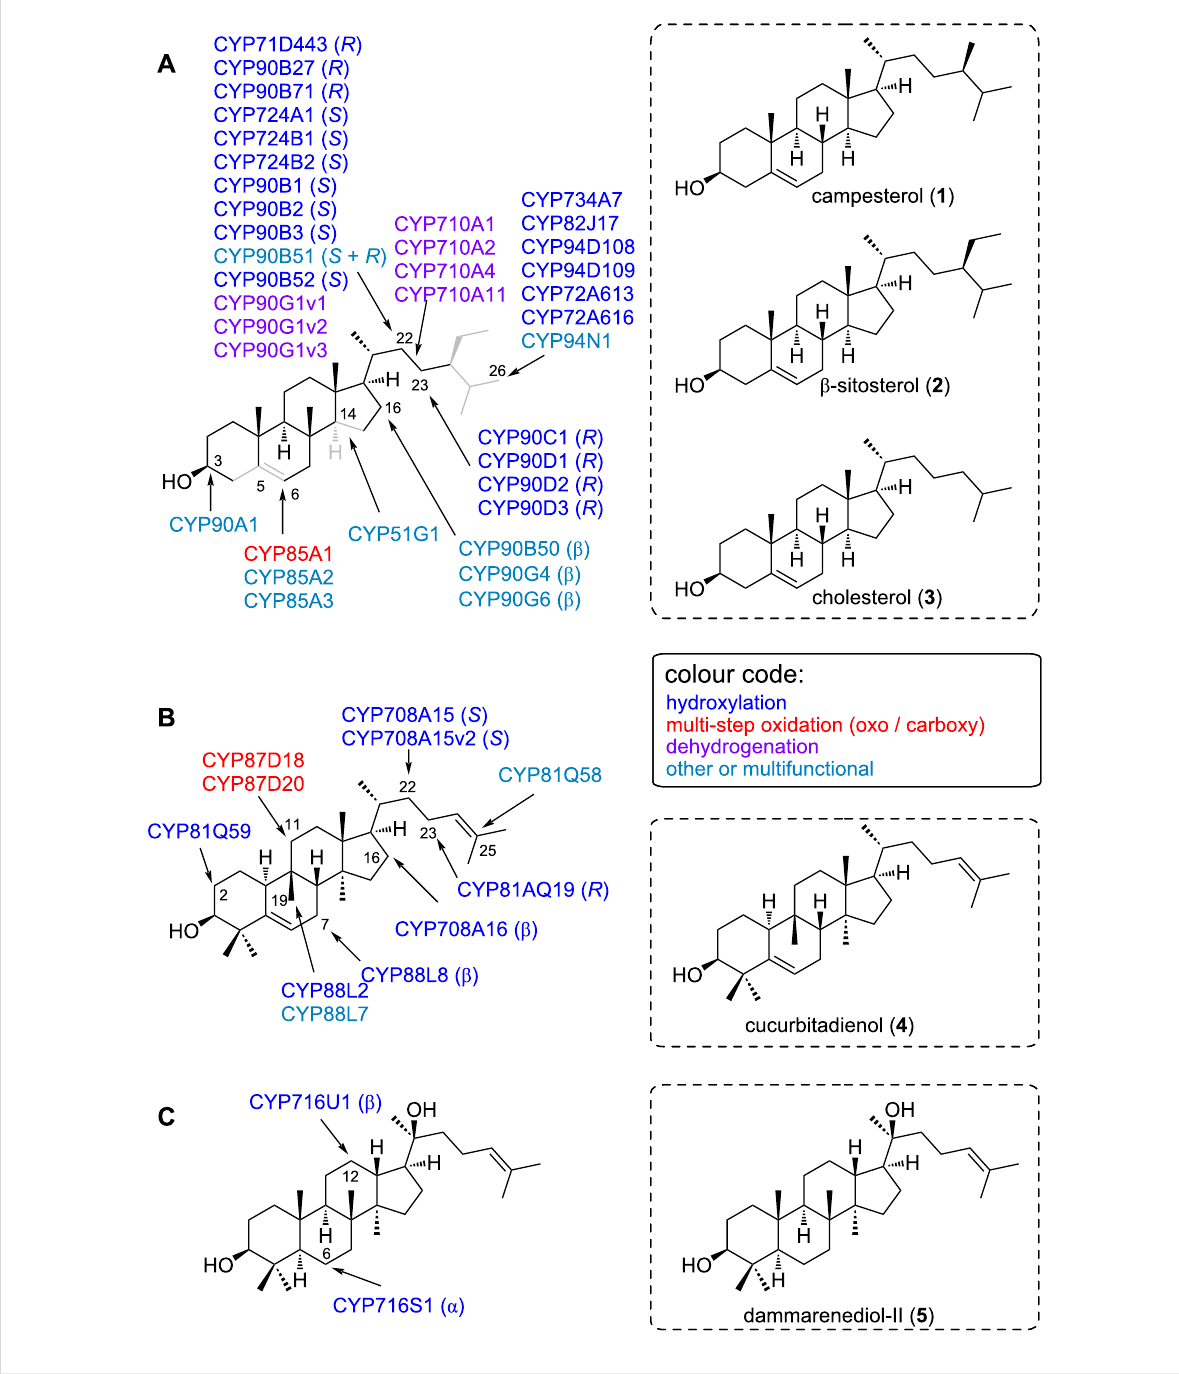
Figure 3: CYPs modifying steroid (A), cucurbitacin steroid (B) and tetracyclic triterpene (C) backbones. Substructures in grey indicate regions where major structural differences occur between different substrates of the same class. Representative substrate skeletons (not exact substrates) are shown in the dotted boxes. For exact substrate specificity see Table